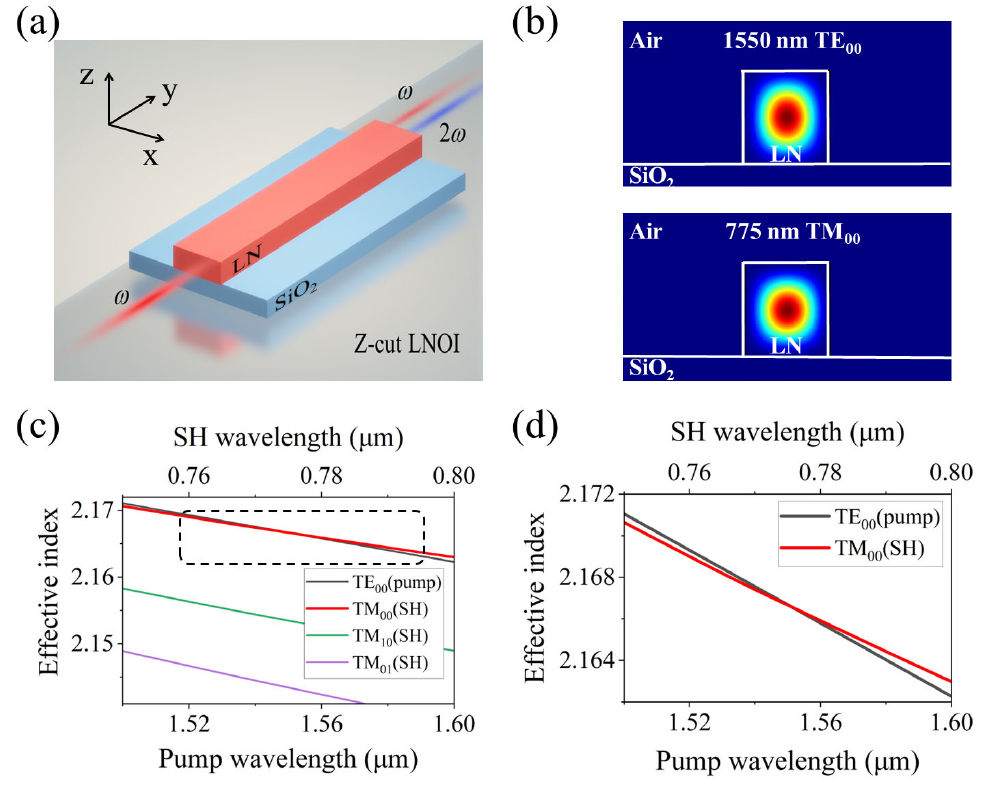
Figure 1. ( a ) Schematic of the z -cut LNOI waveguide structure and working principle of generating second harmonic waves. ( b ) The typical profiles of TE 00 mode of the FW and the TM 00 mode of the SHW in the strip waveguide. ( c ) Dispersion curves for various guided modes in LN waveguide. ( d ) The zoom-in dispersion curves for the curves in the black dash box in panel ( c ).